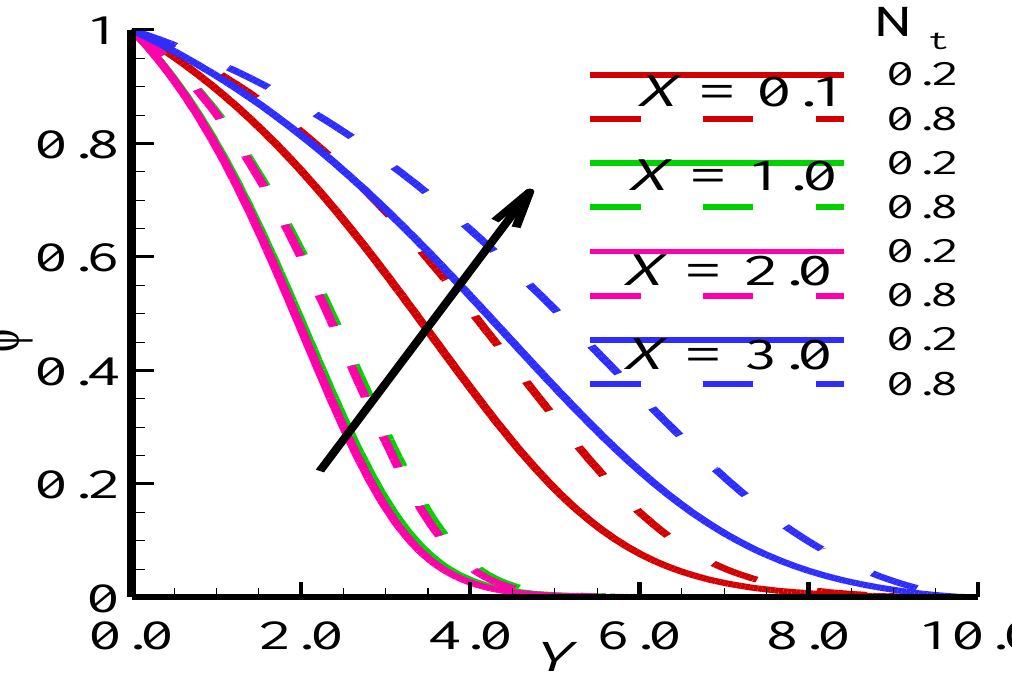
Figure 7. Outcomes of thermophoresis parameter N t on mass concentration φ when N = 0.5, Nb = 1.5, Pr = 7.0, and Sc = 10.0.